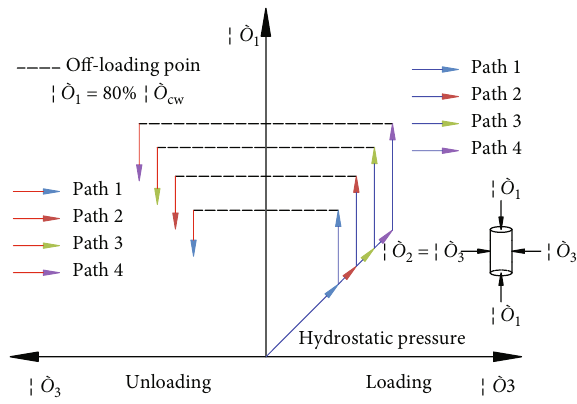
Figure 2: Schematic of stress loading/unloading path.